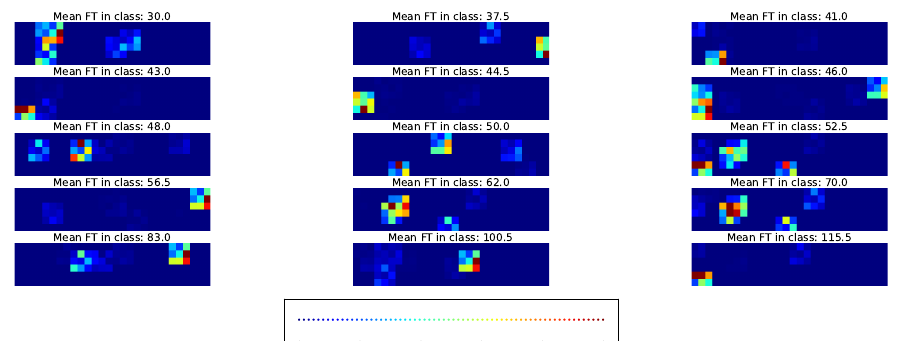
Figure 10. Example of the saliency map for individual acccessions in each time class and cross-SNP set. Figure S1 gives the same data with higher